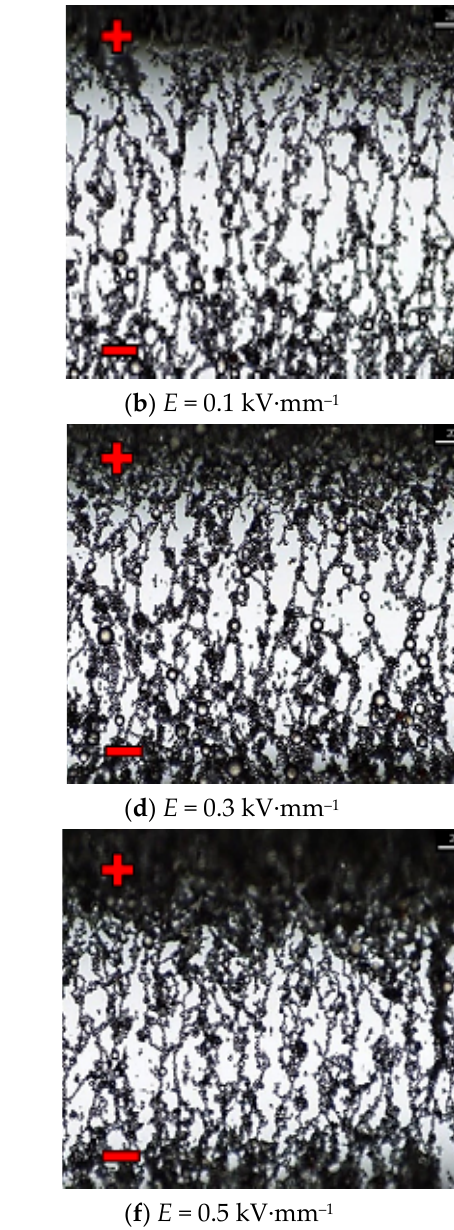
Figure 13. ( a – f ): Liquid LID 3354S in an electric field observed under a Nikon Eclipse LV100D polari-zing microscope.